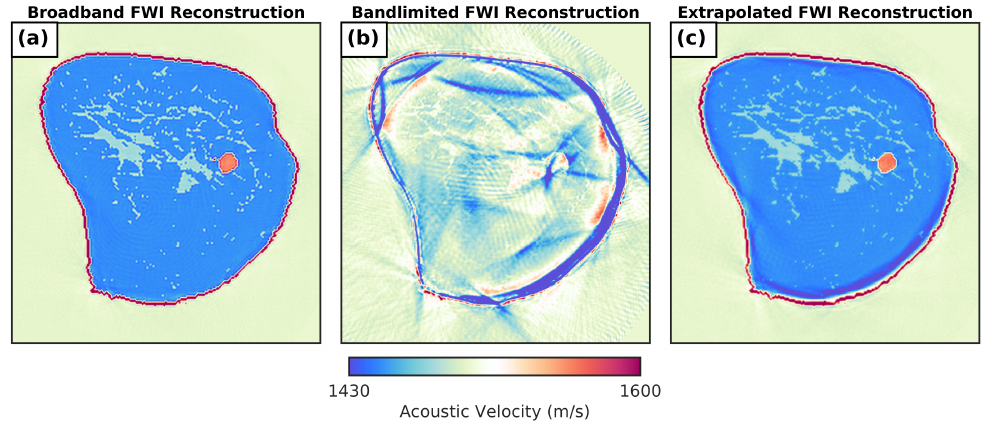
Figure 6. Inversion results for in silico breast imaging data provided by MUST 2019 Data Challenge. ( a ) Full-waveform inversion result using broadband signal data provided for the challenge; ( b ) full-waveform inversion result using narrow-band data acquired by high-pass filtering original broadband dataset; ( c ) full-waveform inversion result using extrapolated broadband data generated using a U-Net CNN to recover missing low-frequency content removed from narrow-band